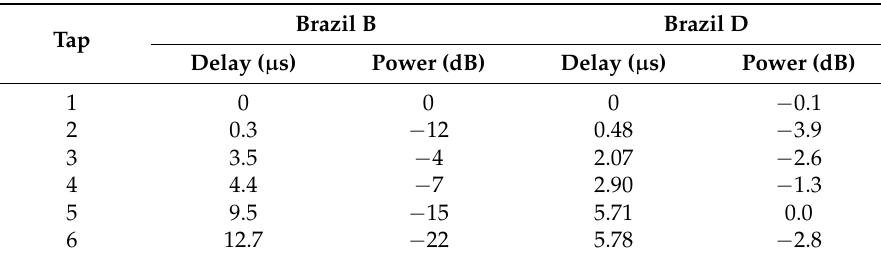
Table 2. Profiles for the Brazil B and Brazil D multipath fading channels.